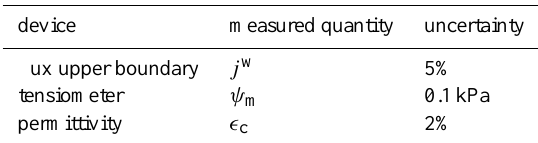
Table 3. Uncertainties assumed for the virtual measurement de-